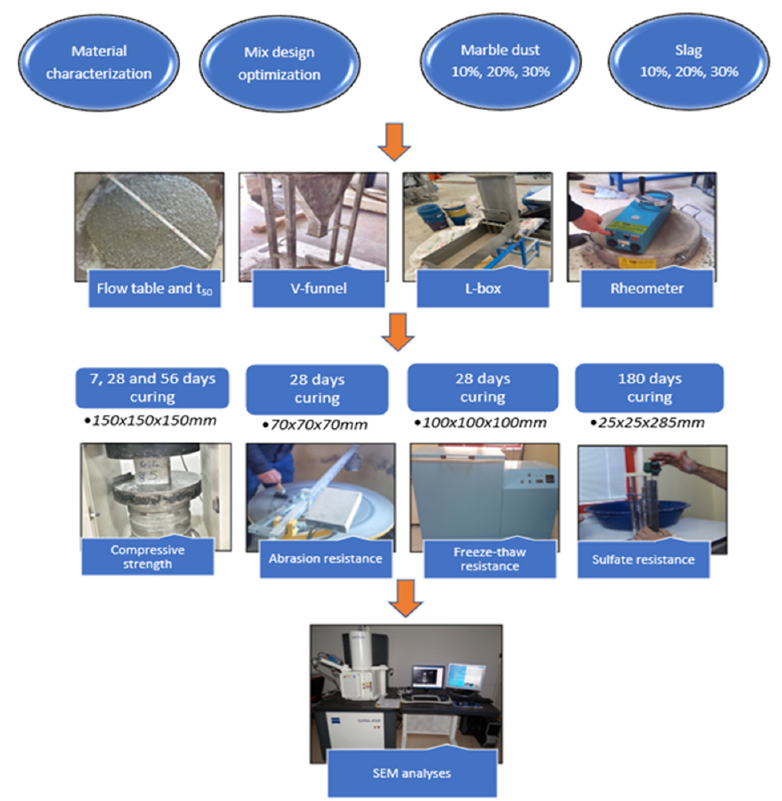
Figure 2. Schematic presentation of the study process.